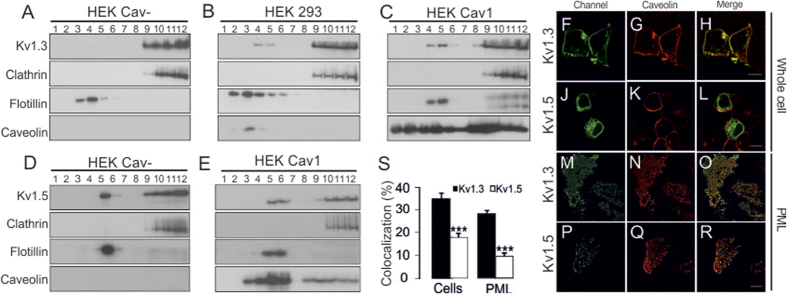
Kv1.3, but not Kv1.5, targeted to lipid raft microdomains in a caveolin-dependent manner.Sucrose-density gradients were performed with total lysates from HEK Cav- (A), HEK 293 (B,D) and HEK Cav1 (C,E) expressing Kv1.3YFP (A–C) and Kv1.5YFP (D,E). Clathrin and Flotillin were used as non-lipid raft and lipid raft markers, respectively. Note that the overexpression of Cav1 (HEK Cav1) partially targeted caveolin to floating (enriched in lipid raft) and non-floating fractions. Colocalization of Kv1.3 (F_H and M–O) and Kv1.5 (J–L,P–R) with caveolin in whole HEK Cav1 cells (F–L) and plasma membrane lawns (PML) (M–R). Green: channel; Red: caveolin; Merge: colocalization in yellow. Bar scale 10 μm. (I) Histogram of the colocalization (%) between channel and caveolin. Closed bars, Kv1.3; open bars, Kv1.5. Data are the mean ± SE of whole-cell (>15 cells) and PML (>35 cells). ***p < 0.001 vs Kv1.3 (Student’s t-test).